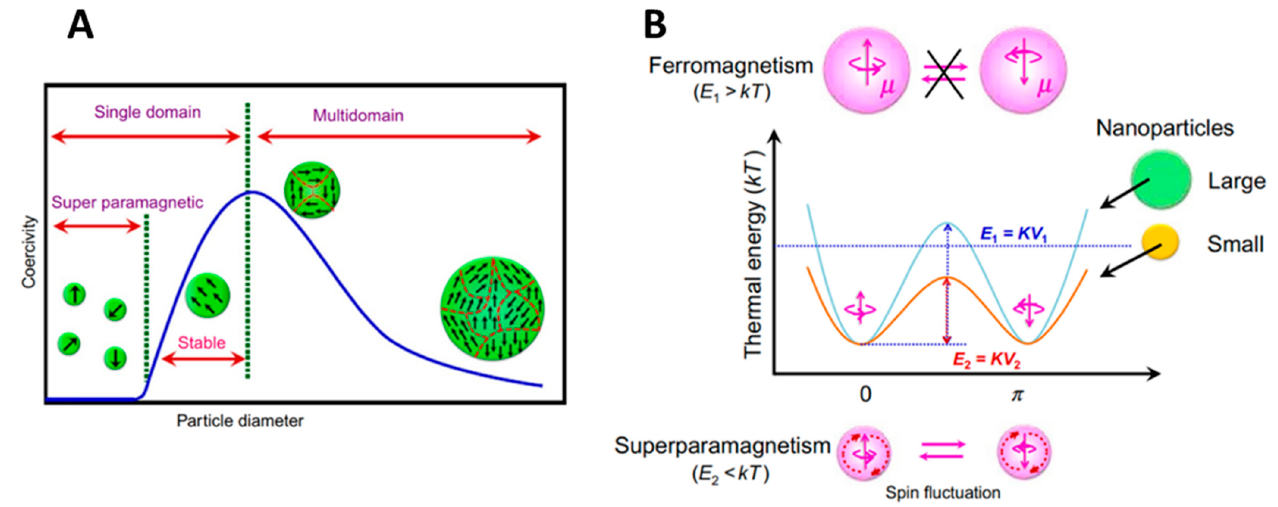
Figure 4. ( A ) Size-reliant domain structures from superparamagnetism to ferri or ferromagnetism. ( B ) Energy diagram of single-domain NPs corresponding to different macrospin alignment ferro- magnetism in bigger particles (up) and superparamagnetism in NP (down) [22]. Reprinted with permission from [22].